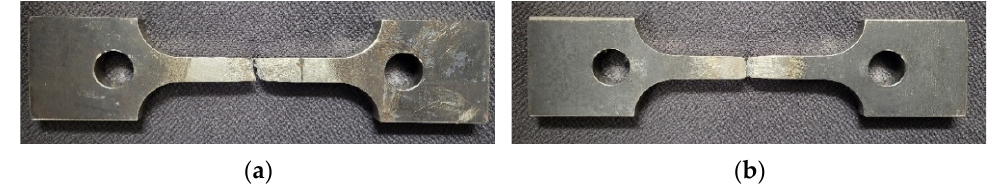
Figure 7. Tensile test specimens for the weld metals: ( a ) high Mn; ( b ) 9% Ni.